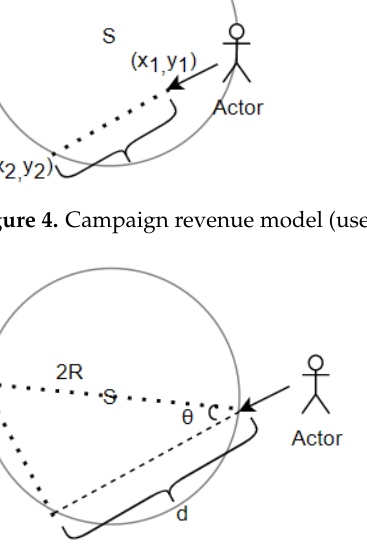
Figure 4. Campaign revenue model (users within the service).